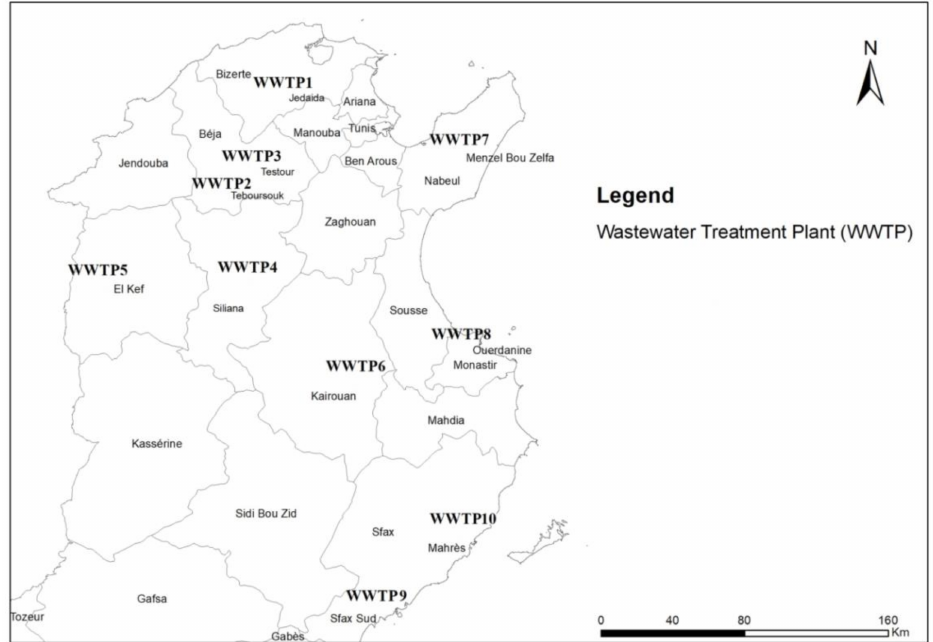
Figure 1. Location of investigated WWTPs with pilot practice for agricultural reuse of sludge